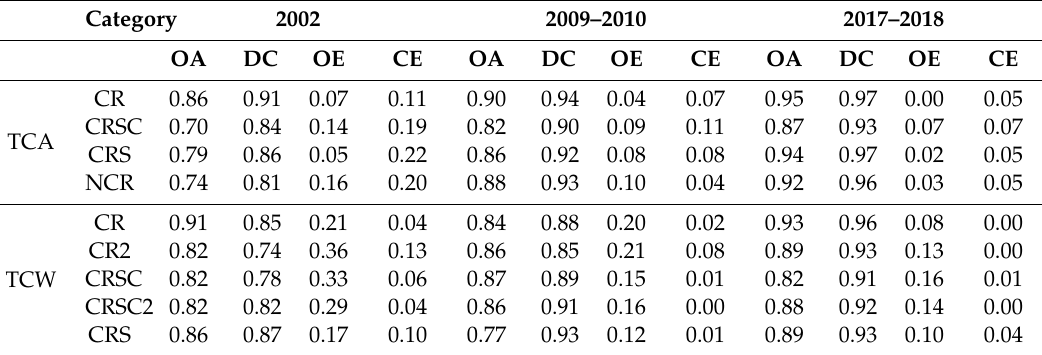
Table 6. Errors metrics for recovery estimation according to TCA and